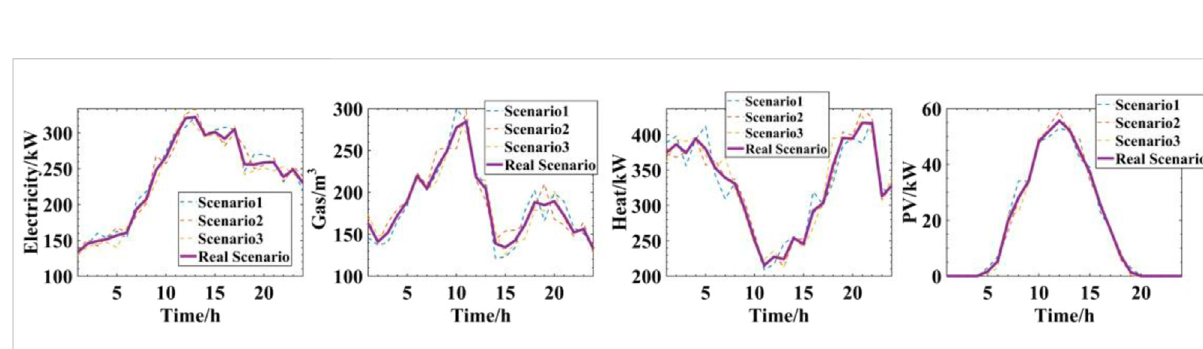
FIGURE 7 Comparisons of the scenarios generated by DCGAN in the day-ahead stage with the actual scenarios.